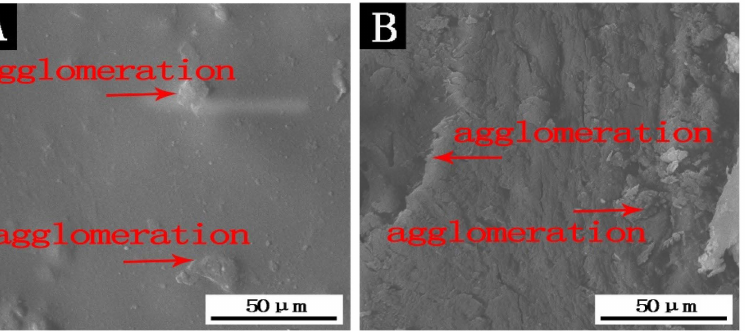
Figure 2. SEM diagrams of topcoat films with different discolouring powder microcapsule content: ( A ) 1.0% and ( B )